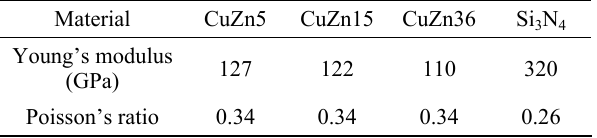
CuZn15, and CuZn36 as well as Si 3 N 4 . The data is acquired from the material datasheets provided by the manufacturers (Wieland-Werke AG and Saint-Gobain